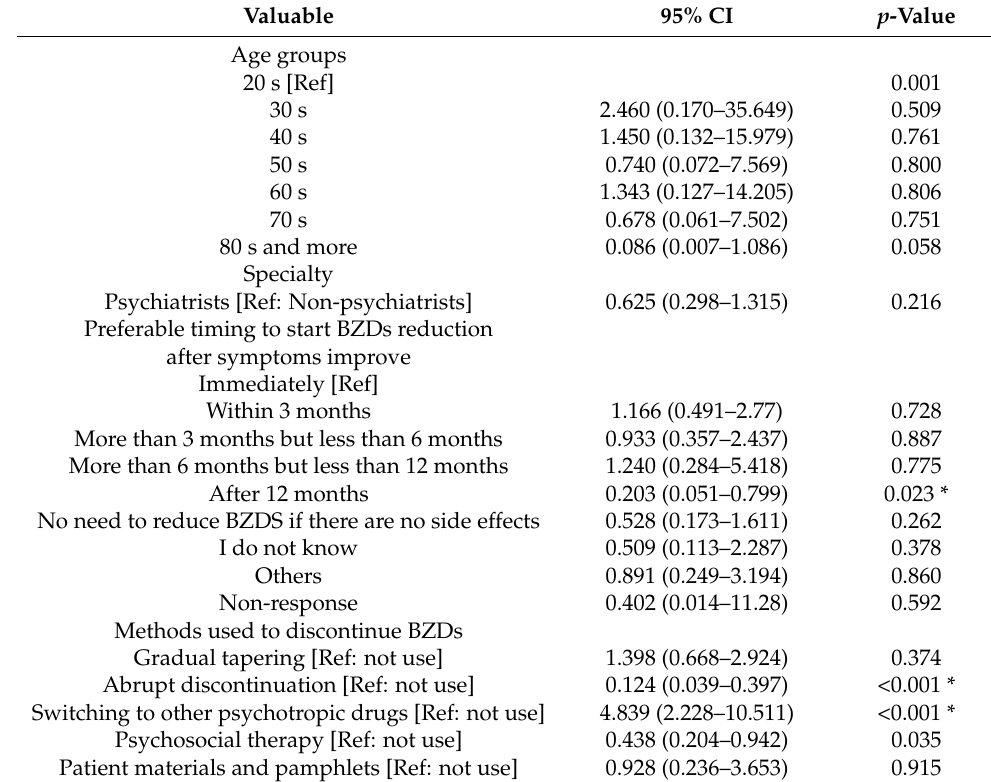
Table 2. Factors associated with difficulties in discontinuing benzodiazepine receptor